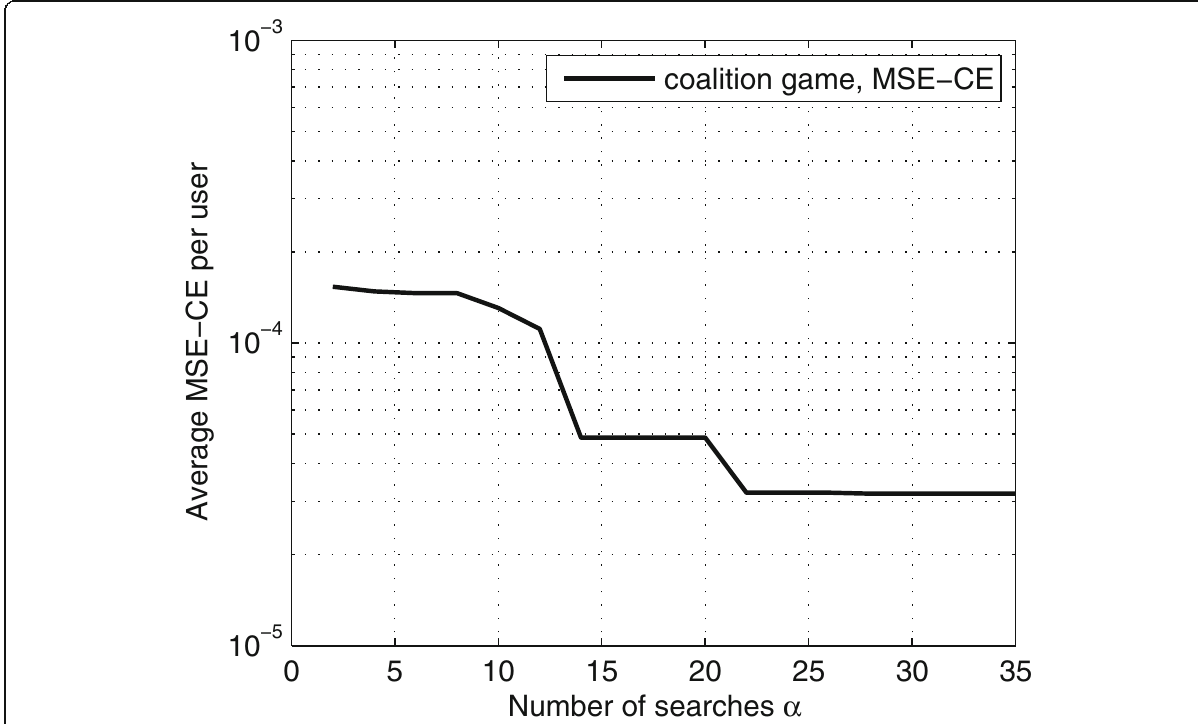
Fig. 4 Average MSE-CE versus the number of searches ( α ) with P = 4 and T = 20 dBW